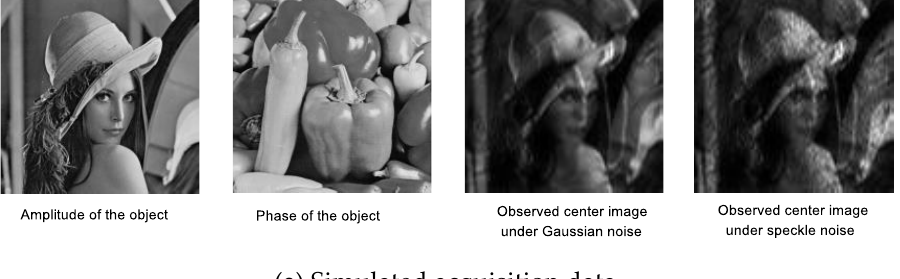
( a ) Simulated acquisition data. Figure 6. Cont